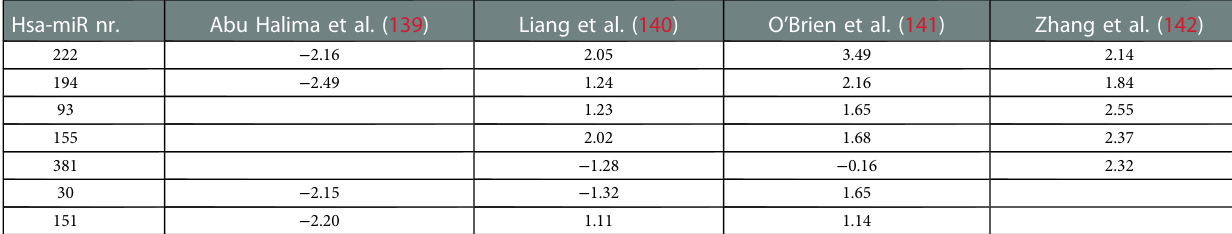
TABLE 1 Heat map of overlapping differentially expressed microRNA in tetralogy of Fallot patients, as fold change compared to controls. Hsa-miR